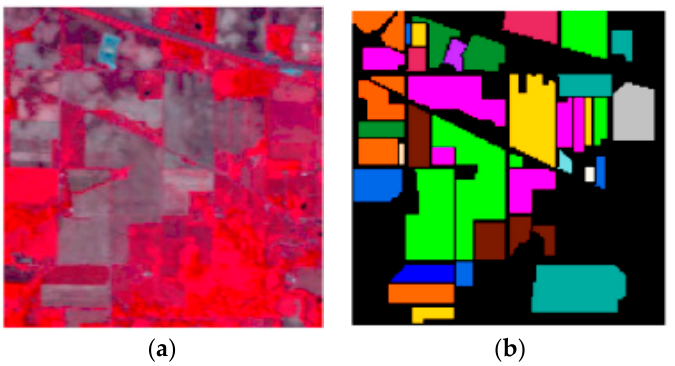
Figure 5. The Indian Pines on Dataset 1. ( a ) shows the composite image; ( b ) shows the groundtruth of Indian Pines dataset, where white area denotes the unlabeled pixels. Table 1. Ground truth of classes and their respective sample size on Indian Pines scene.